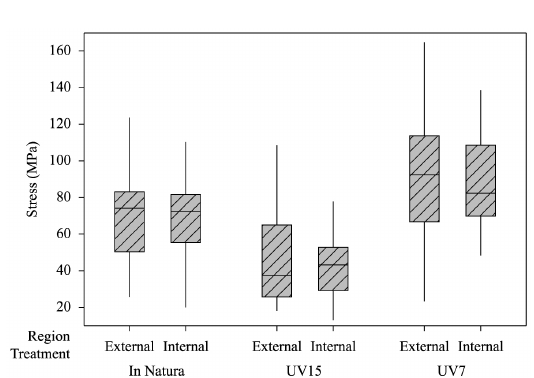
Figure 3. Boxplot of BFs tensile strength. Bibliographic source: Author.